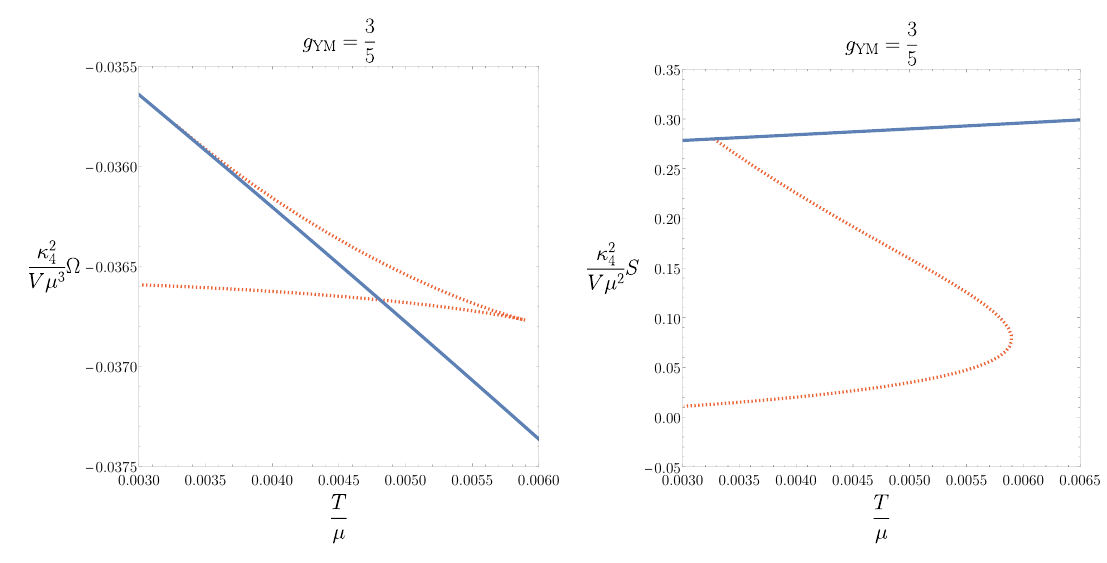
Figure 5. The entropy S as a function of temperature for both normal (blue) and con- densed (red, dashed) phase with g YM = 3 / 5 . At T = T c , the condensed curve is not contin- uous as following the normal curve down past T = T c , there is discontinuous jump to the lower condensed curve branch. The behaviour exhib- ited in these plots is therefore that of first order phase